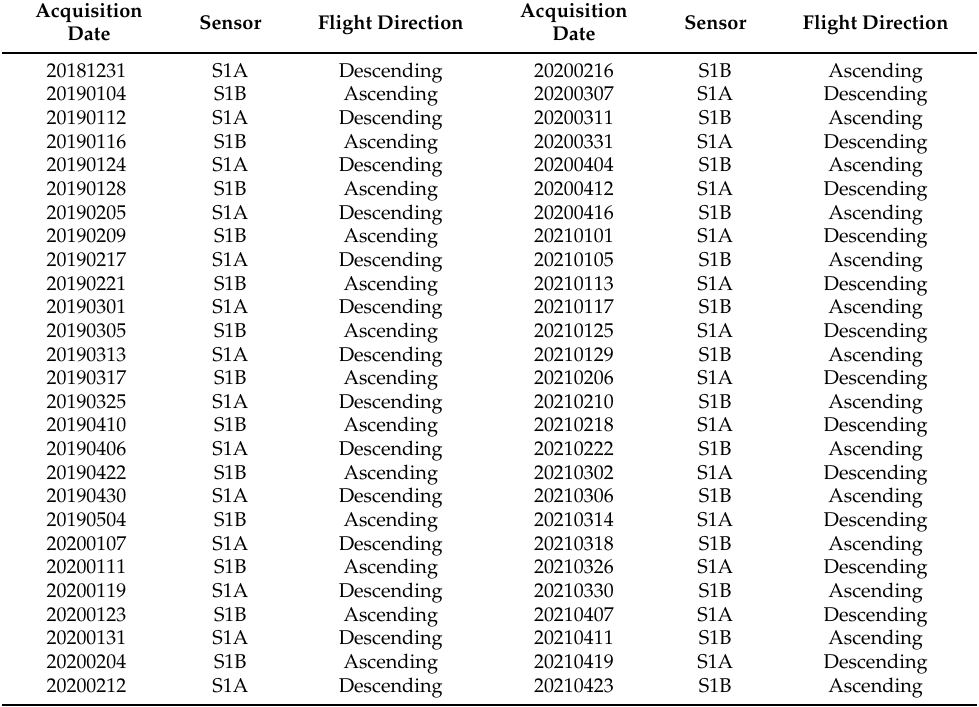
Table A1. List of collected SAR